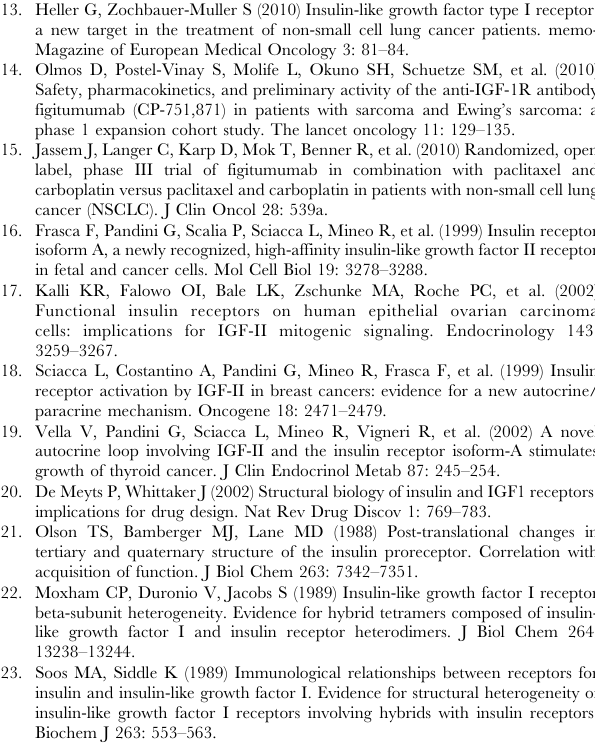
Figure S5 Anti-proliferative effect of figitumumab on MCF7 cells. MCF7 breast cancer cells were used as a positive control for ELISA. The cells were treated with increasing concentrations of figitumumab (0, 0.1, 1.0, 10 m g/mL) for 120 hours to inhibit the growth of control cells by 30%. Six replicate wells were included in each analysis, and at least three independent experiments were conducted. The data from replicate wells are presented as the mean of the remaining cells. Bar= 6 SE. Figure S6 Effect of figitumumab on insulin mediated IGF1R/IR heterodimeric receptors. Figitumumab could not inhibitinsulin-mediatedsignalsoraffecttheformationofIGF1R/IR heterodimericreceptors.A)Allcellswereserum-starvedfor24 hours, and then treated with insulin (100 nmol; 30 min) or figitumumab (10 m g/mL; 4 hours). SNU719 cells were incubated for 4 hour at 37 u C with figitumumab followed by stimulation with insulin for 30 minutes. Total cellular extracts (1 mg) were extracted using IP buffer (pH 7.4), immunoprecipitated with anti-IR antibody, and Western blotted with anti-IGF1R antibody. The blot was then stripped and reprobed with anti-IR b antibody to ensure equivalent loadingofanti-IRantibodyinallsamples.B)Effectoffigitumumabon insulin-mediated IGF1R signaling. SNU719 cells were serum- starved for 24 h and then treated with insulin (100 nmol; 30 min) orfigitumumab(10 m g/mL:4 h).ThecelllysateswerethenWestern- blottedwiththeindicatedantibodies.Representativeblotsfromthree independent experiments are shown. Figure S7 MS/MS spectra of glycosylated